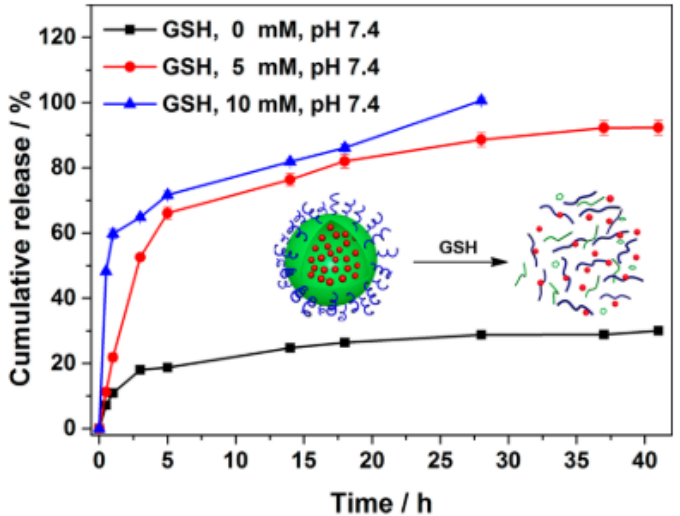
Figure 5. Doxorubicin release from polymeric particles at different concentrations of GSH, at the same temperature [22]. Reprinted with permission from Xu et al. ACS Biomaterials Science and En-